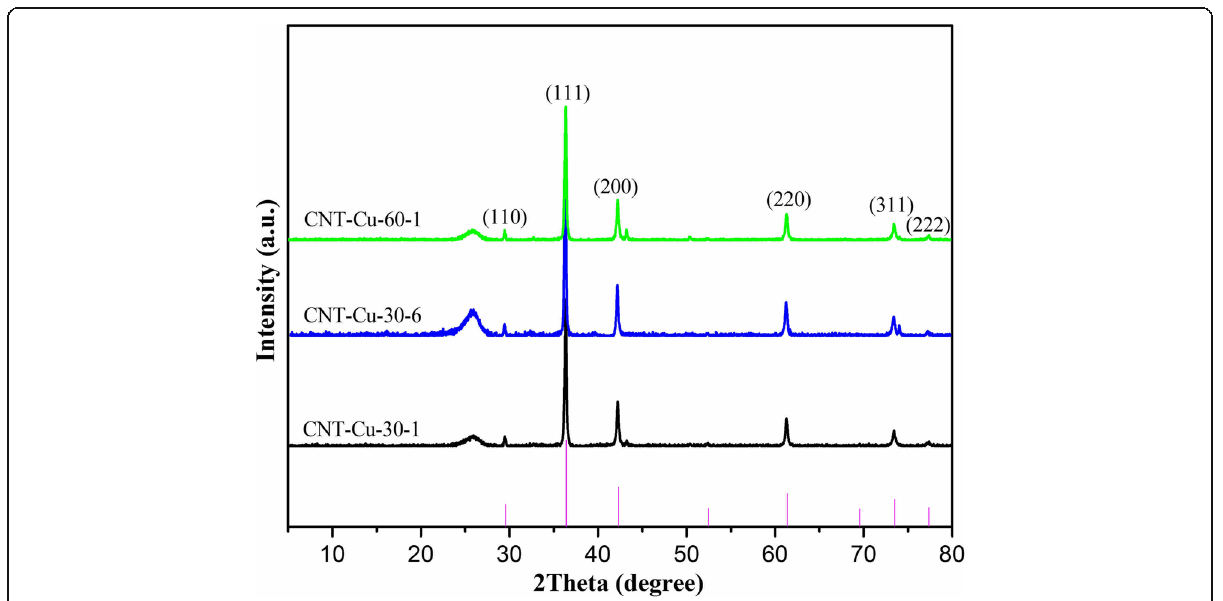
Fig. 3 XRD curves of the synthesized CNT-Cu 2 O